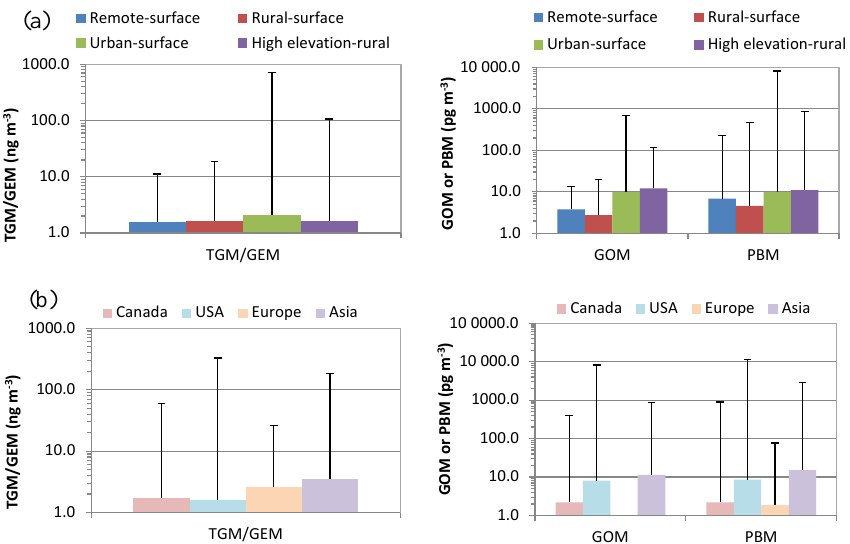
Figure 2. Median and range in TGM/GEM, GOM and PBM by site category (a) and by geographical region (b) . Bar graph represents the median and error bar represents the maximum, estimated from the values in the literature as shown in Tables S4 – S6.